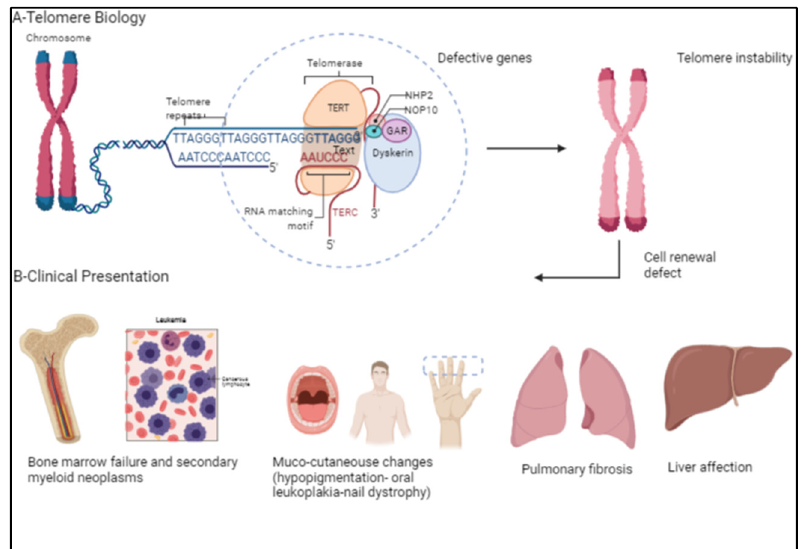
Figure 1. ( A ) Demonstrates telomere biology and the various genes involved in telomere elongation. ( B ) Telomere instability causes classical clinical presentations in patients with dyskeratosis congenita, namely bone marrow failure, secondary myeloid neoplasms, mucocutaneous changes, pulmonary fibrosis, and liver disease. [Created with BioRender.com] (BioRender, Toronto, ON,